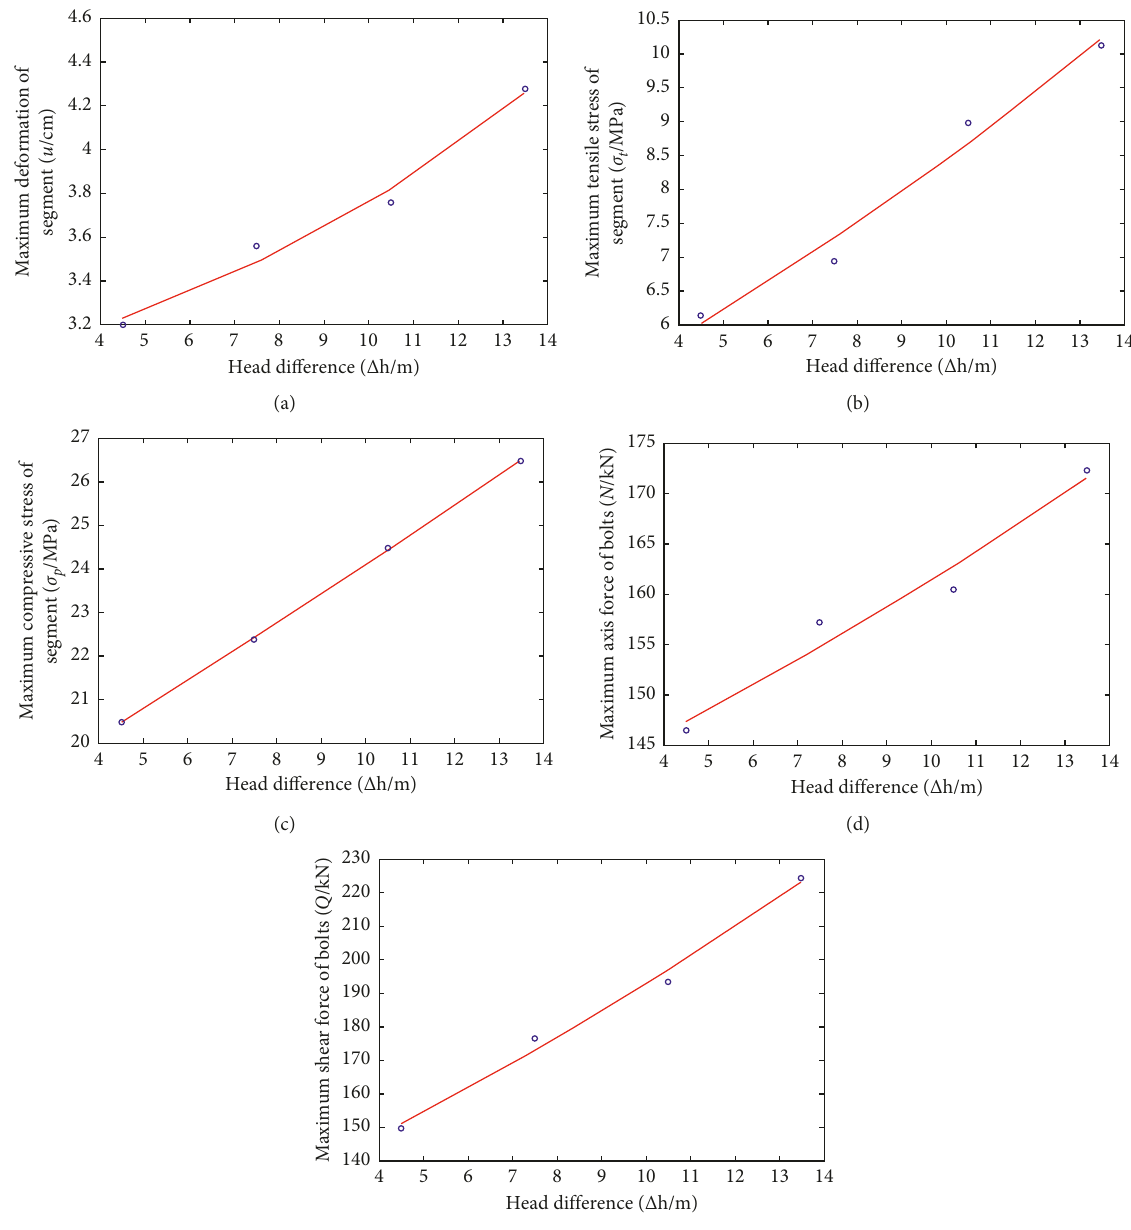
Figure 17: Maximum deformation value of the segment corresponding to the water head difference. (a) Maximum deformation value of the segment corresponding to the water head difference. (b) Maximum tensile stress of the segment corresponding to the water head difference. (c) Maximum compressive stress of the segment corresponding to the water head difference. (d) Maximum axial force of the bolt corresponding to the water head difference. (e) Maximum shear force of the bolt corresponding to the head